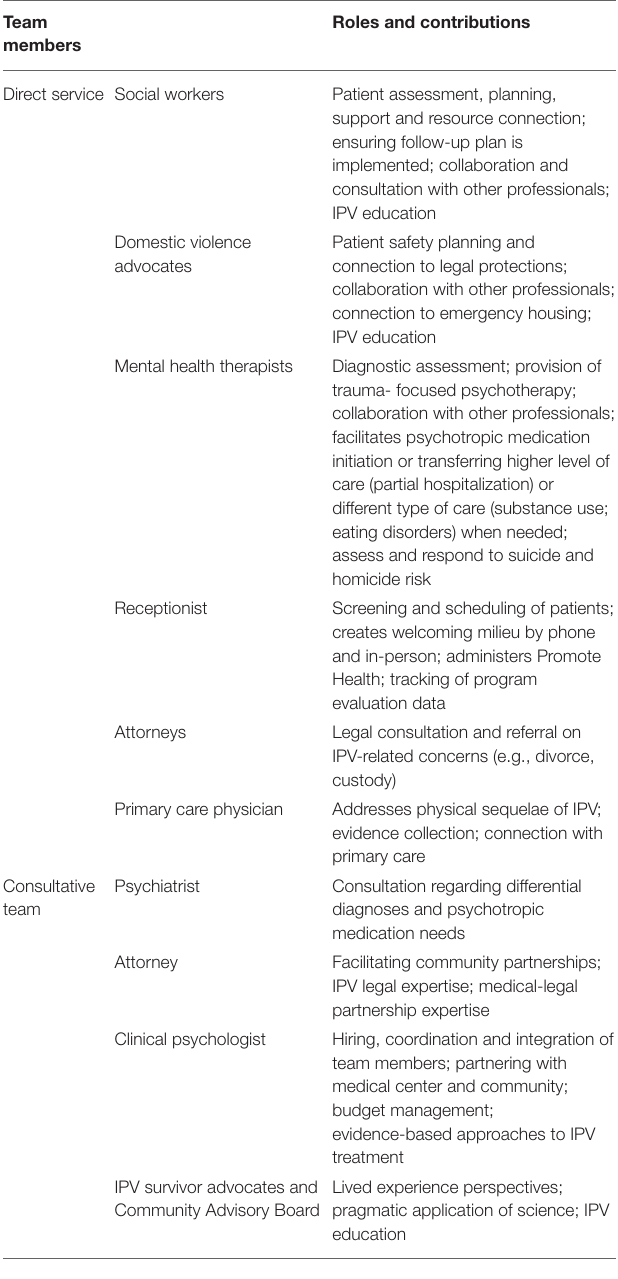
TABLE 1 | HEAL collaborative interprofessional team members. Team